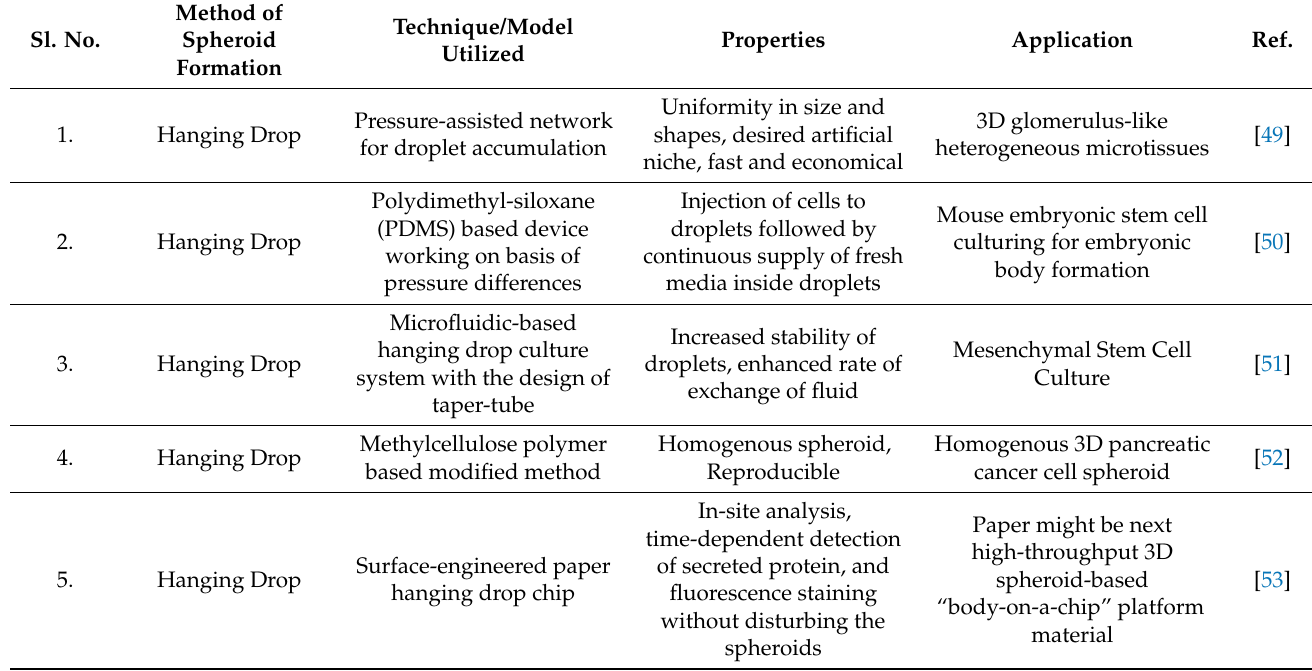
Table 3. Recent applications of various methods employed in spheroid